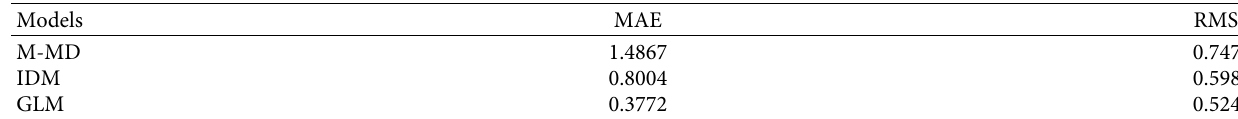
Figure 8: Time-acceleration curves of model simulation. (a) Vehicle 97 follow vehicle 93. (b) Vehicle 173 follow vehicle 122. (c) Vehicle 234 follow vehicle 222. Table 4: Models error